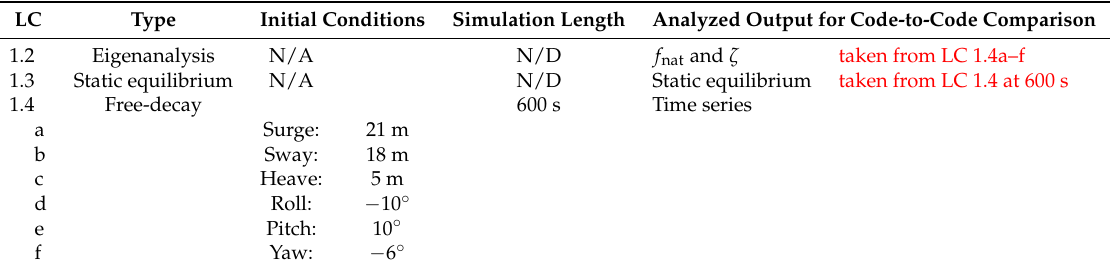
Table 6. Simulation settings and analysis methods for load case (LC) group 1.x, assumptions and modifications are written in red.